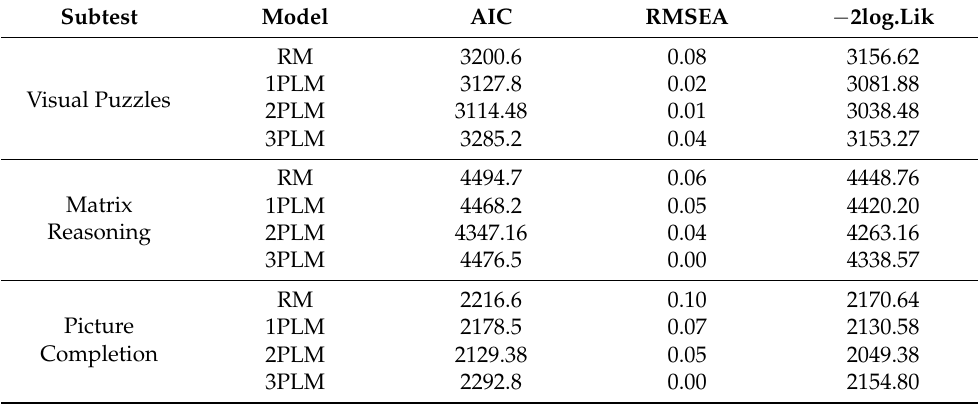
Table 3. AIC, M2, RMSEA, and LRT analysis for dichotomous WAIS-IV